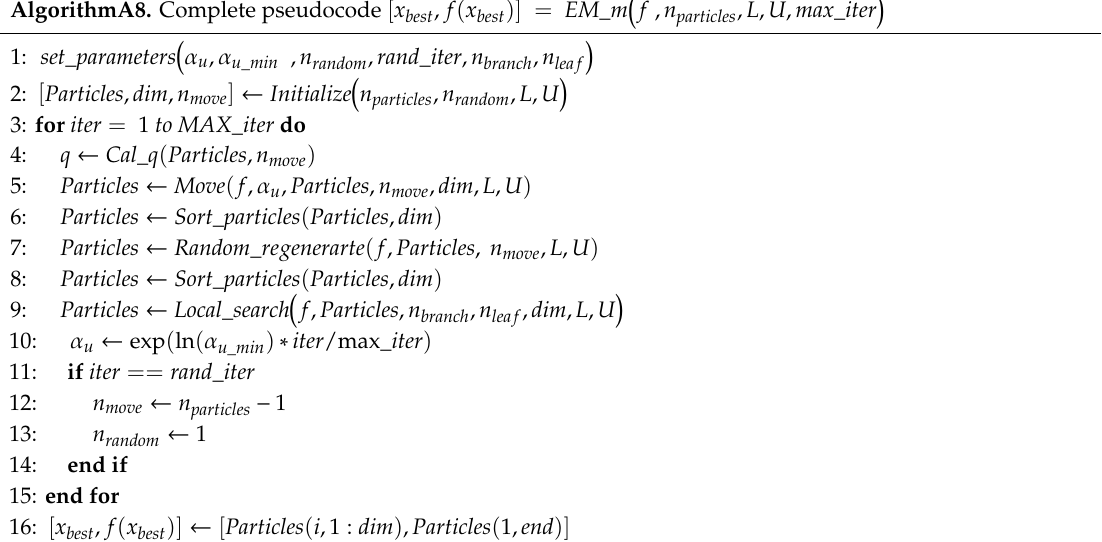
(cid:16) f , n particles , L , U , max _ iter